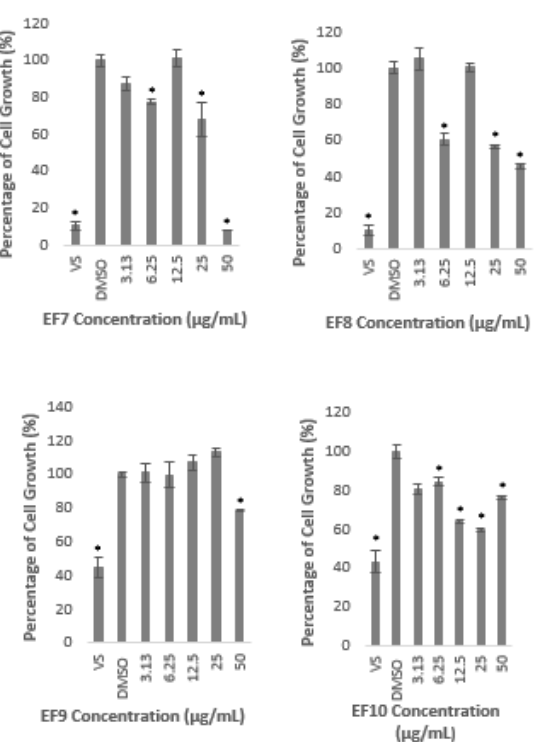
Figure 2. Percentage of cell growth of HepG2 after the treatment with A. planci fractions at five different concentrations from 3.13 to 50 µg/mL for 72 h. The percentage of cell growth was compared to the negative control of 1% ( v / v ) of DMSO which was used as the carrier. Data obtained presented as mean ± SD with n = 6. EF represents the fraction number. * denotes significantly different as compared to DMSO-treated cells (negative control) at p < 0.05. DMSO was used as the carrier to dissolve and dilute the extract.